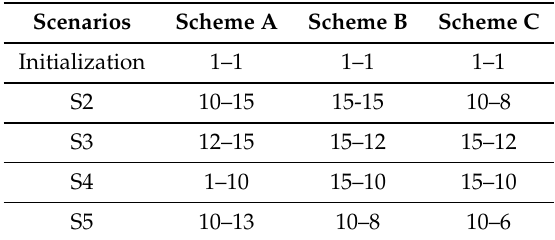
Table 4. Recommended window filter configurations based on the rules defined (window step size–window